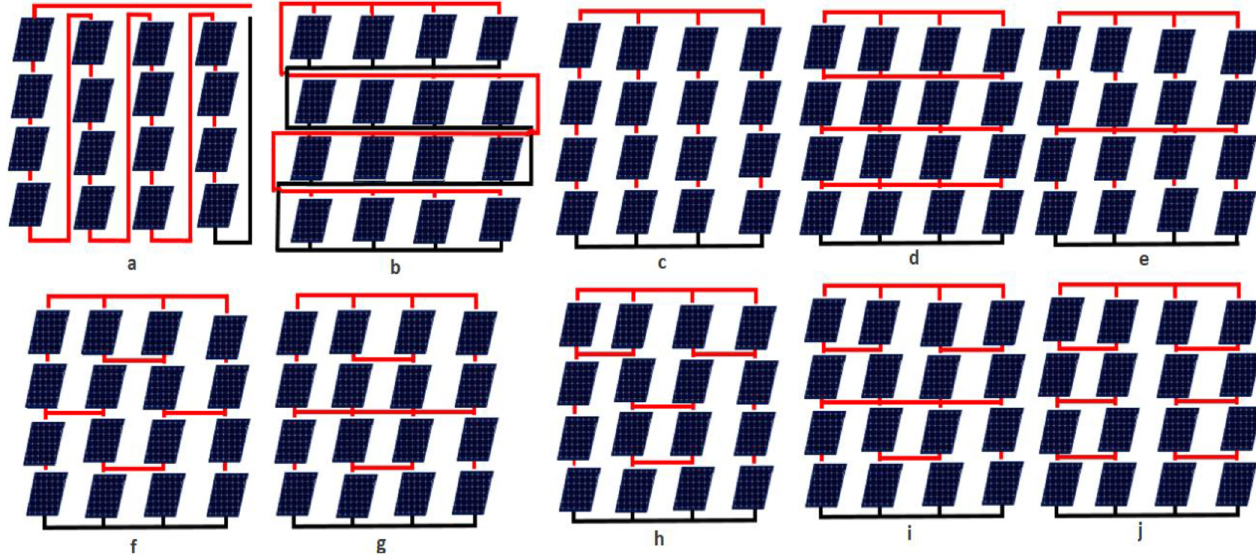
Fig. 5. PV modules interconnection con fi guration schemes schematics; (a) S, (b) P, (c) SP, (d) TCT, (e) CCT, (f) BL, (g) BLTCT, (h) HC, (i) HCTCT, (j)